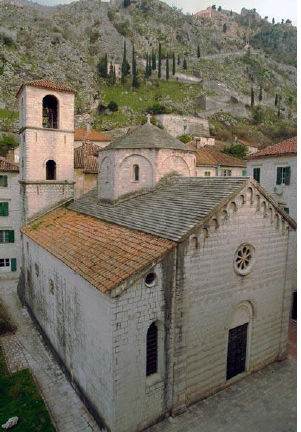
Figure 6. Church of St. Mary of the River from the 13th century.